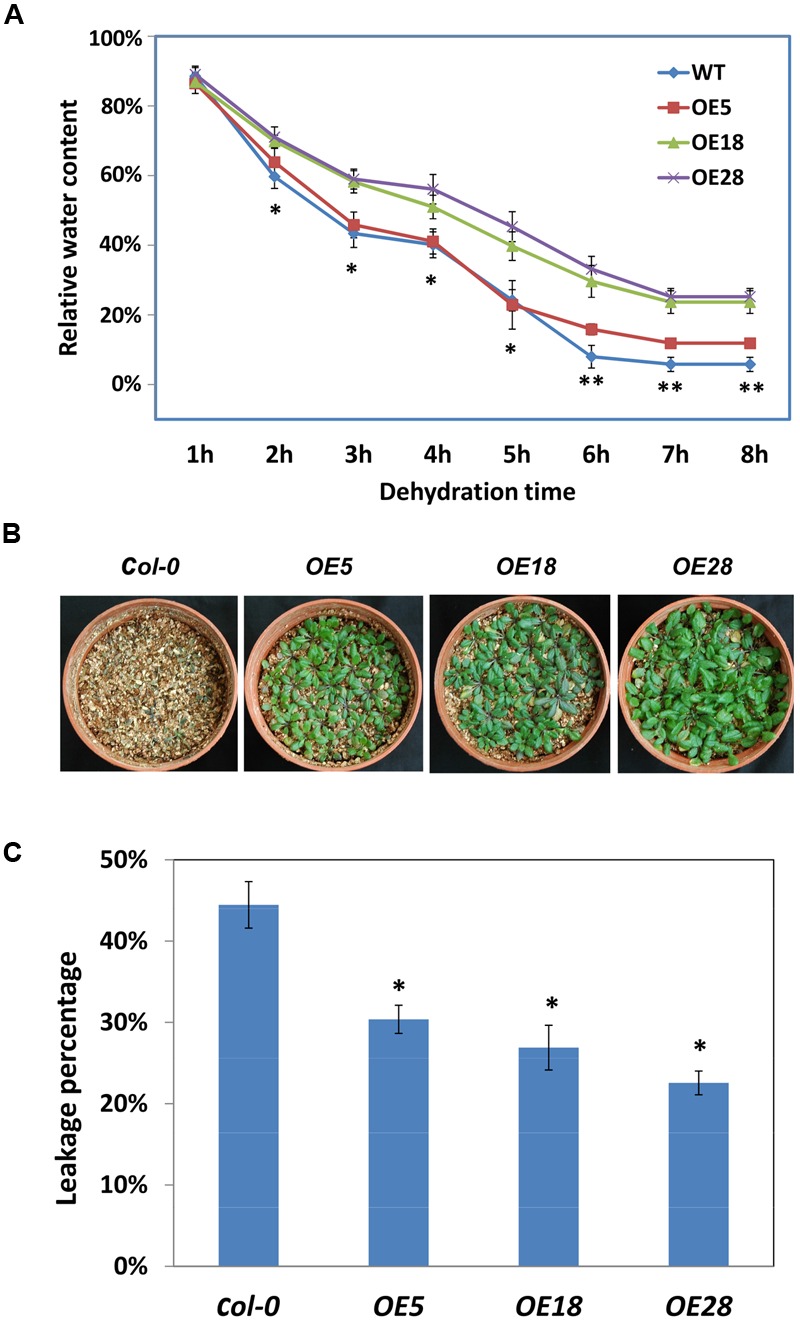
HbEBP1 overexpression conferred drought and cold resistance in Arabidopsis. (A) The dehydration rates of leaves from the Col-0, OE5, OE18 and OE28 seedlings. An asterisk (∗)indicates a significant difference between Col-0 and the individual OE18 and OE28 lines, whereas a double asterisk (∗∗) indicates a significant difference between Col-0 and each individual HbEBP1 OE line. (B) Representative seedlings of the Col-0, OE5, OE18 and OE28 lines after irrigation were withheld for 7 days. The seedlings were grown in a pot containing vermiculite, and the drought stress treatment was conducted with 2-week-old seedlings by withdrawing water for 1 week. The photos were taken 3 days after re-irrigation. (C) Electrolyte leakage of leaves from the Col-0, OE5, OE18 and OE28 lines. Electrolyte leakage was measured using leaves from 2-week-old seedlings frozen to -7°C at a cooling rate of 1°C/h from -1°C. An asterisk (∗) indicates a significant difference between each individual HbEBP1 OE line and the wild type Col-0 seedlings. Data in (A,C) are presented as the mean ± SEM from five biological replicates. Significance was determined by the Student’s t-test at the probability levels of p < 0.05. Comparisons were made between Col-0 and each individual OE line.